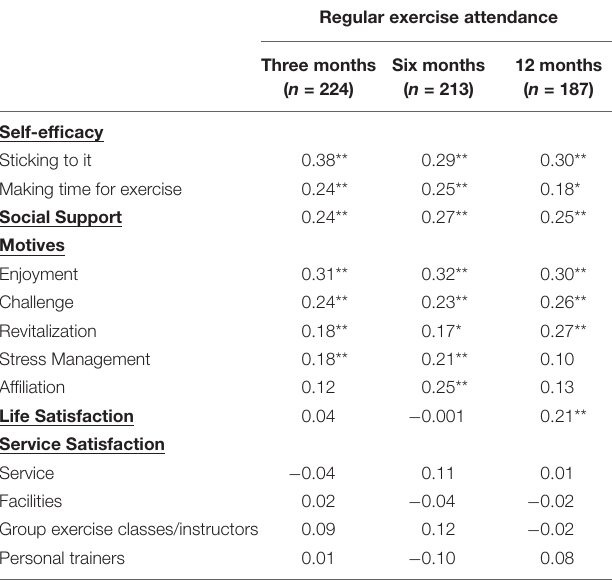
TABLE 2 | Pearson’s correlations between regular exercise attendance and psychosocial factors and service